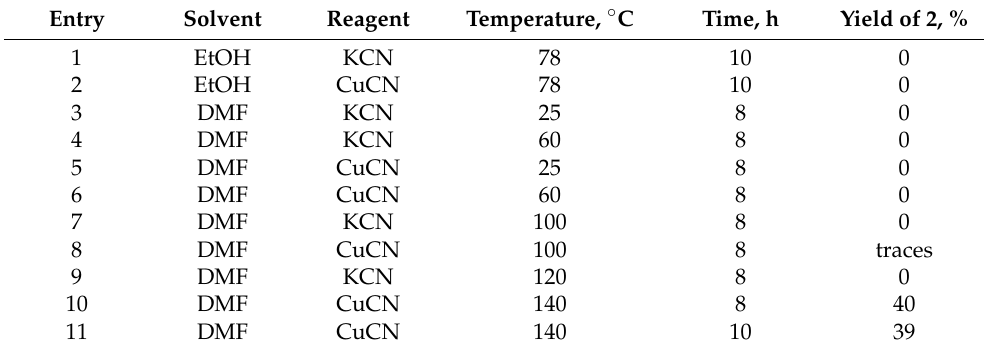
Table 1. Reaction of 2,5 ‐ dibromo ‐ 3,4 ‐ diaminopyridine 2 with metal cyanides (2.2 equiv).